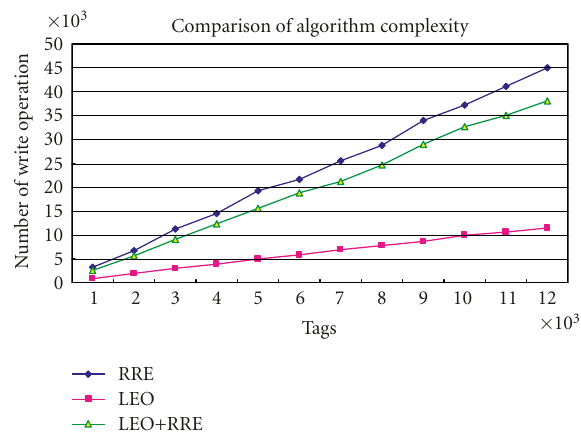
Figure 9: Comparison of number of write operations with network area 10000 × 10000, reader radius = 500, and number of readers = 500.